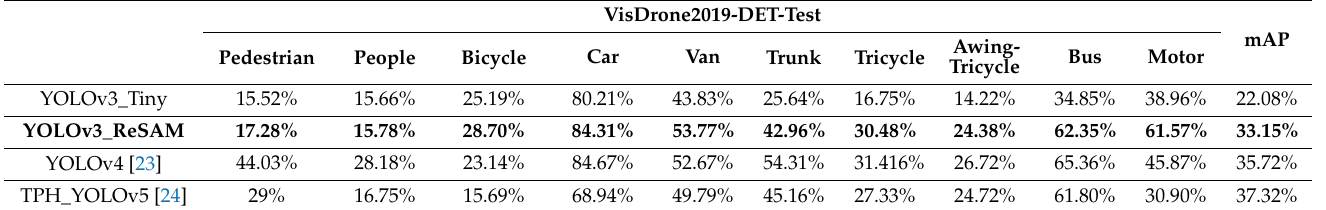
Table 1. Average precision of various targets under different network models (Bold is an improved model based on YOLOv3-Tiny).